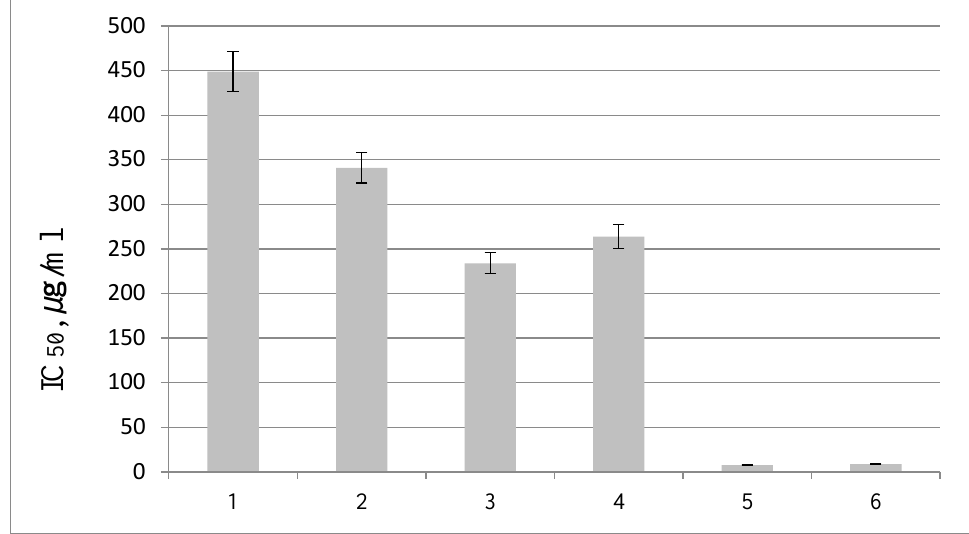
Figure 5. DPPH radical –scavenging activity of S. betulifolia ssp. aemiliana extracts. IC 50 , µg/mL, is the antioxidant concentration that causes 50% inactivation of the DPPH radical. 1: MshS, day 60; 2: MshL, day 60; 3: IP s ; 4. AP s; 5: trolox; 6: ascorbic acid.